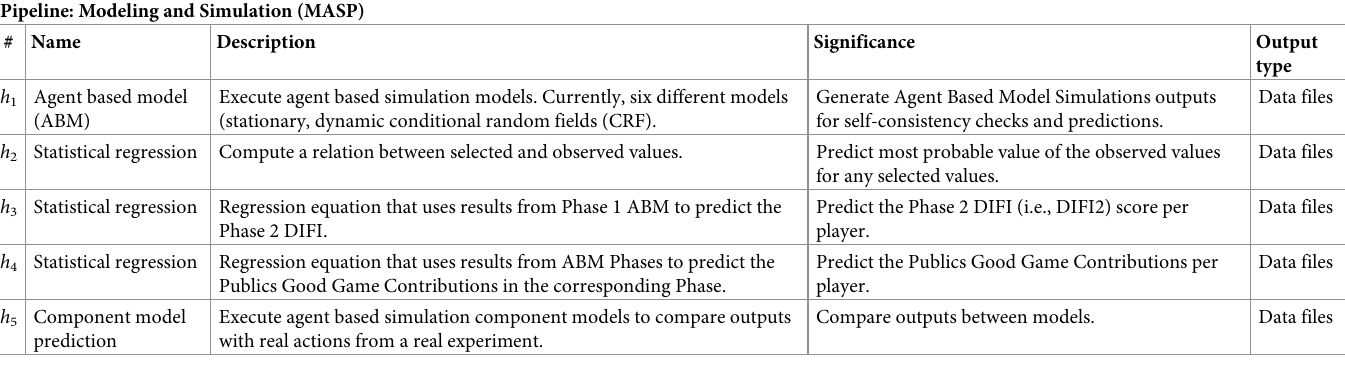
Table 12. Listing of types of functions as microservices for the (4) Modeling and Simulation Pipeline (MASP). Pipeline: Modeling and Simulation (MASP)